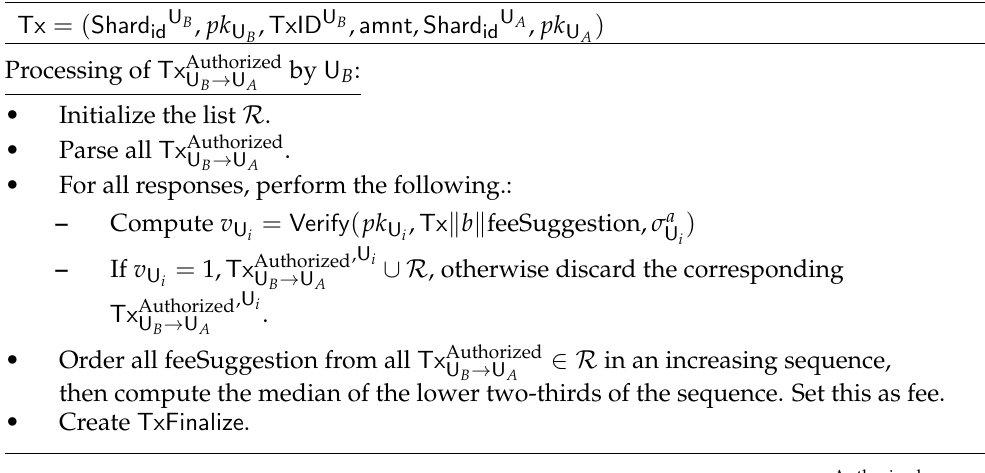
Figure A2. The process for how U B responds to the authorization answers, Tx Authorized U the